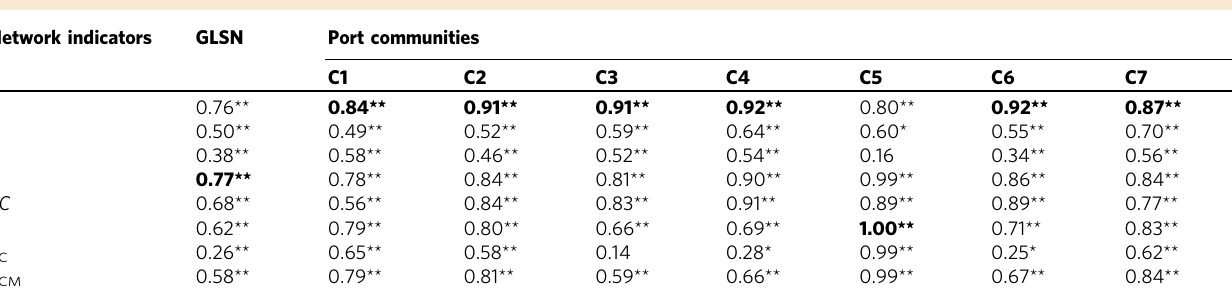
Table 1 Pearson correlation coef fi cients between network indicators and port